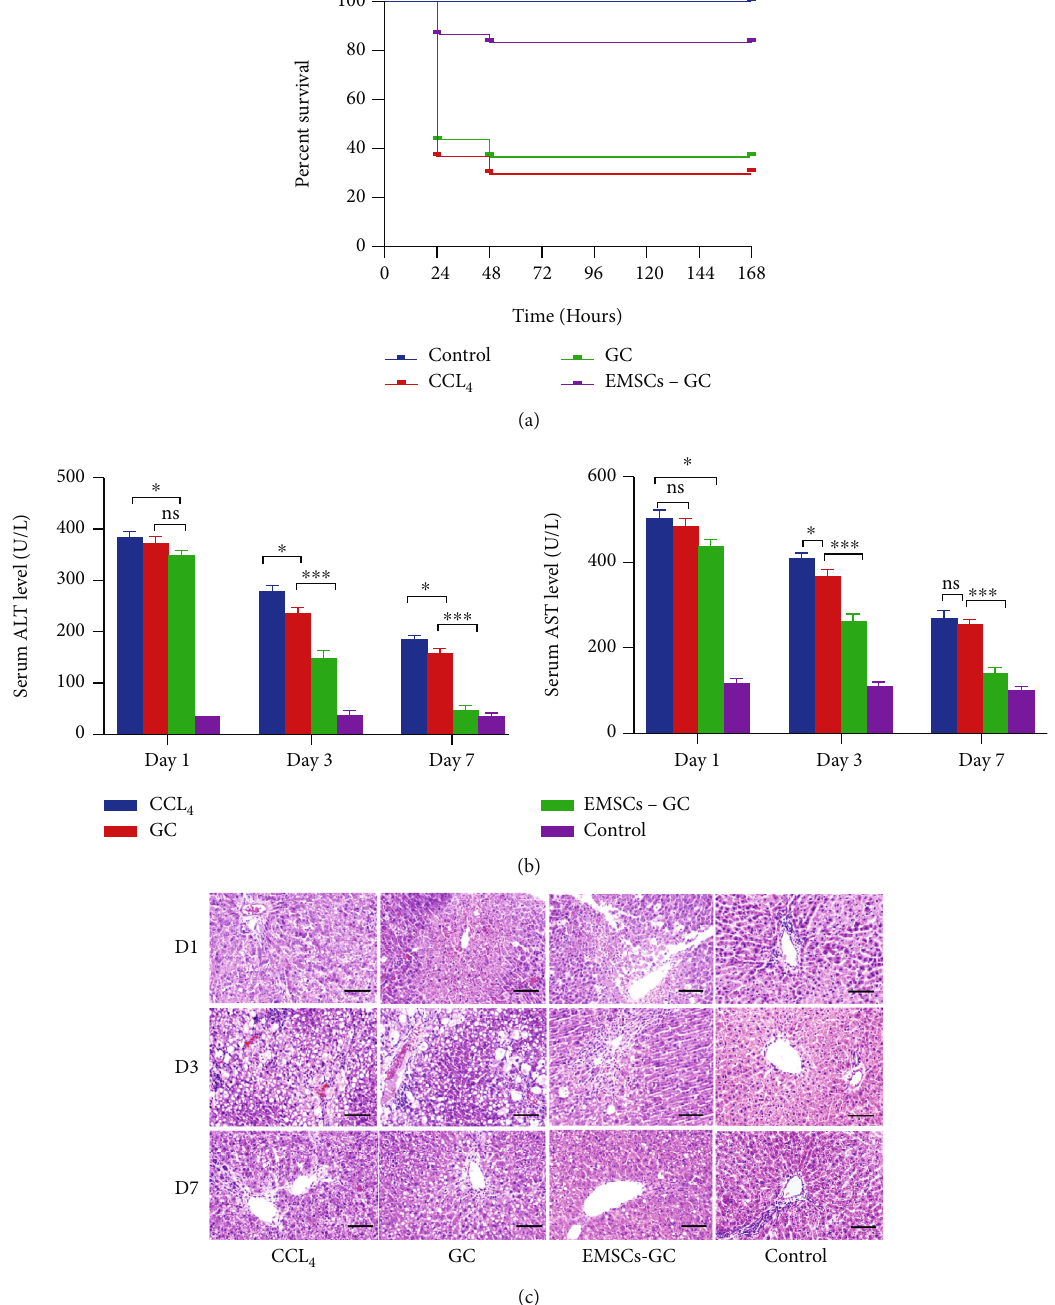
Figure 3: EMSC transplantation increased survival and reduced liver injury in ALF rats. (a) Survival analysis of each group. (b) Liver -treated rats on days 1, 3, and 7 after GC and EMSC-GC matrices. (c) Representative liver tissue pathology function analysis in CCl 4 H&E staining (200x magni fi cation) on di ff erent days after GC and EMSC-GC matrix transplantation. The EMSC-GC matrix groups group. Scale bar = 200 μ m show smaller congestion areas than the CCl 4